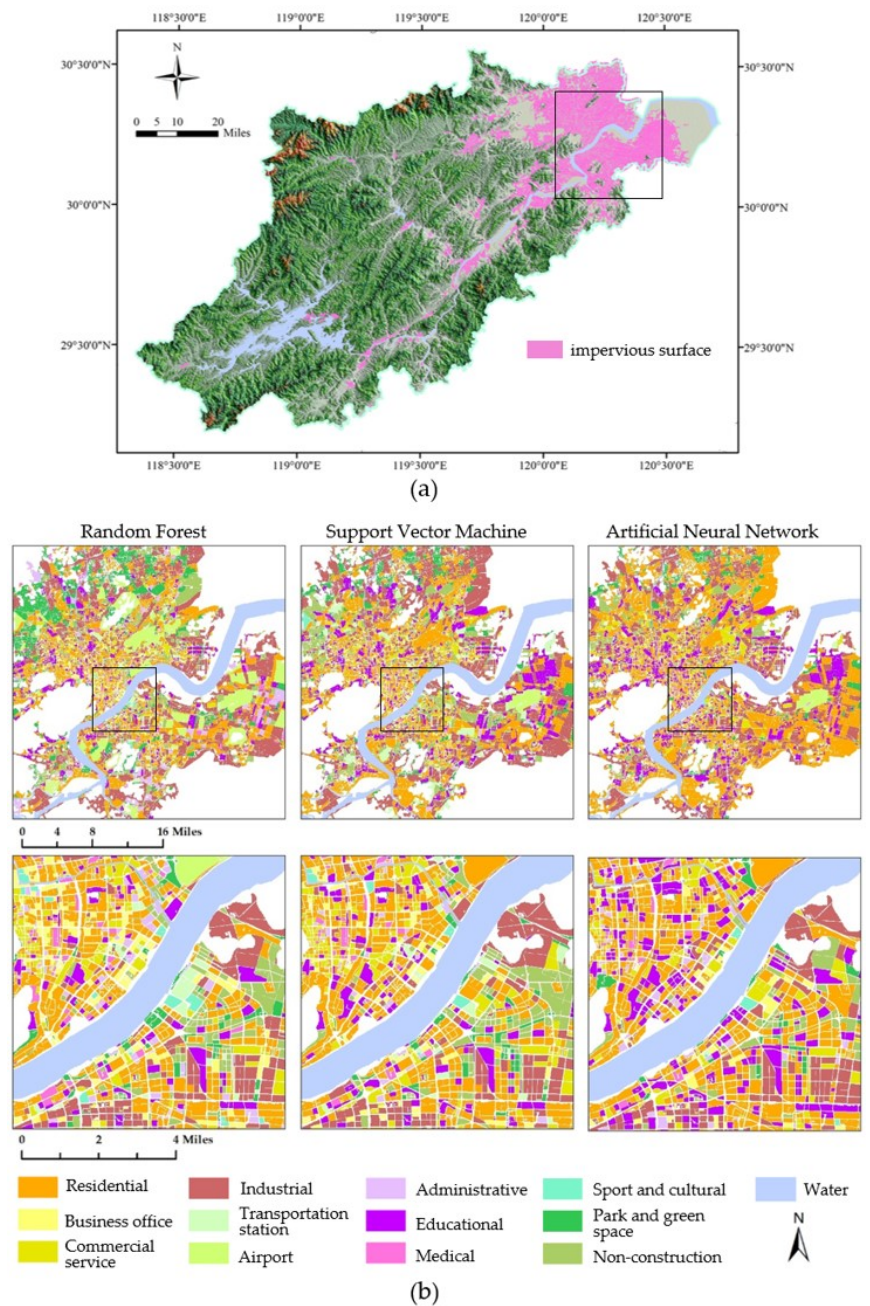
Figure 6. The spatial distributions of the Level II land use in Hangzhou, 2018. ( a ) Impervious surface in urban boundaries; ( b ) Detailed zoomed-in view map of the downtown area.